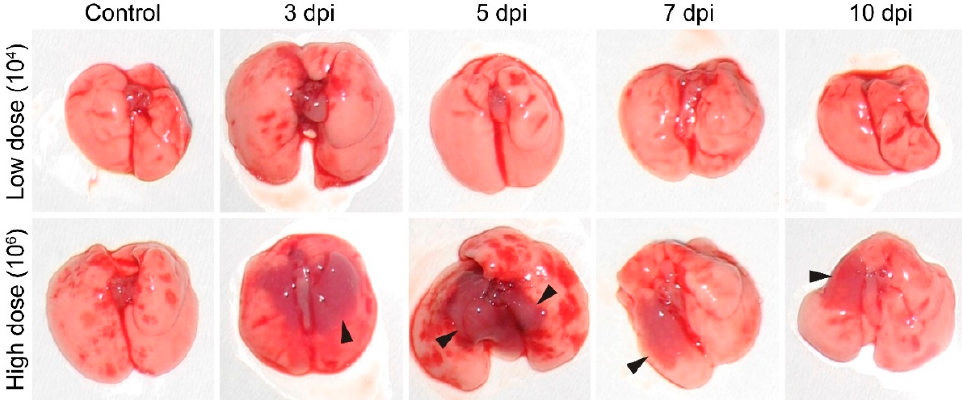
Figure 3. Gross pathology of the lungs in A/JOlaHsd mice. The animals were sacrificed by terminal blood collection under anesthesia, and the gross pathology of the lungs was observed. Photographs of gross lung specimens collected at 3, 5, 7, and 10 dpi are shown. Note the dark red areas in the lung parenchyma (black arrowheads). Tissue from noninfected, healthy animals is referred to as a control.